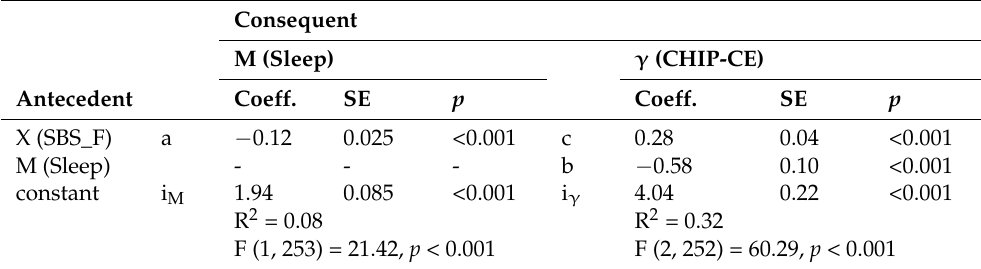
Table 7. Mediation effect of the sleep quality in the link between secure base support from the father (SBS_F) and overall well-being.